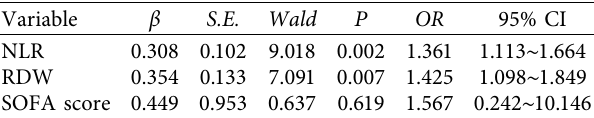
Table 3: Multivariate logistic regression analysis on those afecting the prognosis of emergency patients with